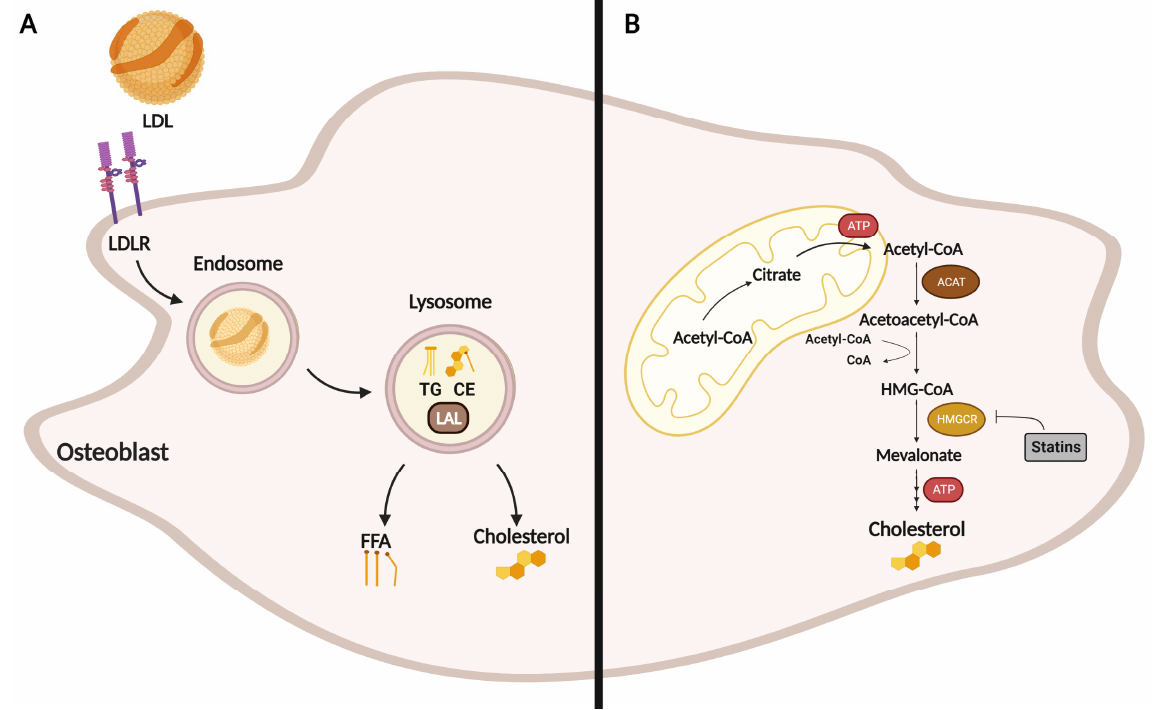
Figure 2. Osteoblast cellular cholesterol homeostasis. ( A ) Exogenous LDL uptake in osteoblast via LDL-LDLR endocytosis is an important source of CE and TG for lysosomal hydrolysis. Lysosomal acid lipase (LAL)-mediated lipid catabolism leads to the release of free cholesterol and free fatty acids (FFA) for further cellular needs. ( B ) Cholesterol formation begins with acetyl-coenzyme A (CoA), two molecules of which are converted into acetoacetyl-CoA by acetyl-CoA acetyltransferase (ACAT). The first step in the mevalonate pathway from 3-hydroxy-3-methylglutaryl (HMG)-CoA to mevalonate is catalyzed by HMG-CoA reductase (HMGCR), which is the main target of statins. This figure was created using Biorender.com (accessed on 13 March